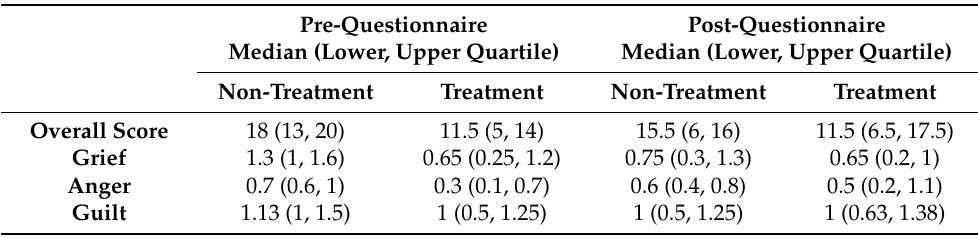
1 Scores for analysis were calculated as in Hunt and Padilla [35]. The overall bereavement score was calculated by summing the answers for the 16 questions for each individual participant. Scores for each of the three subfactors were calculated by taking the average response to the questions within each subcategory (grief = 7 questions; anger = 5; guilt = 4). The change in overall bereavement and all four subfactors over the 8 week study period was